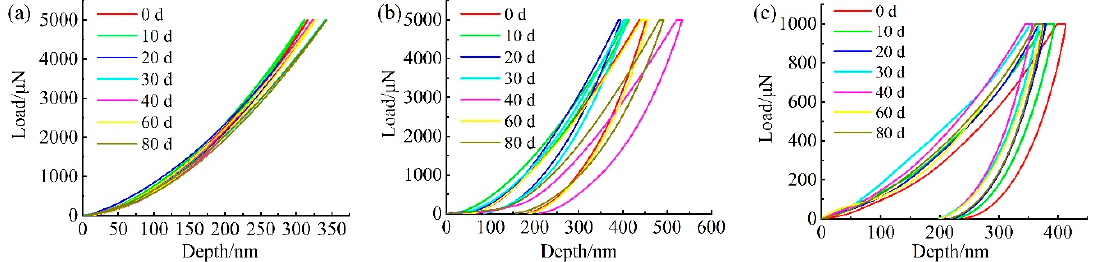
Figure 19. Nanoindentation test load vs. indentation depth curve at different aging times: ( a ) fiber phase; ( b ) interface phase; ( c ) matrix phase.